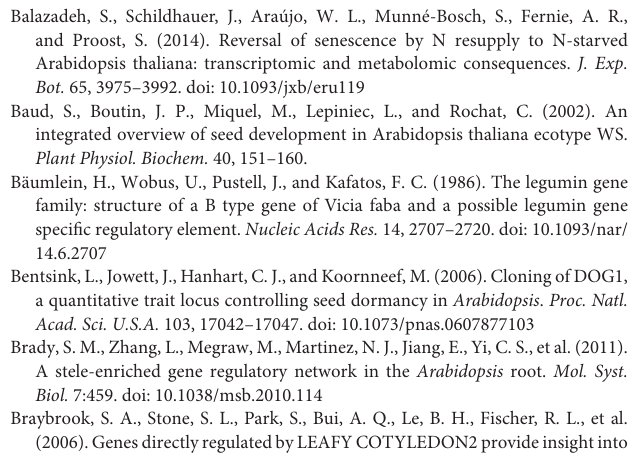
Supplementary Table 2 | Lists of differentially-expressed genes in seeds at 10 DAP between dof4.1-3 and wild type. Genes more expressed in dof4.1-3 (sheet1) or in wild type (sheet 2) seeds. p-adj: adjusted p -value using false discovery rate correction